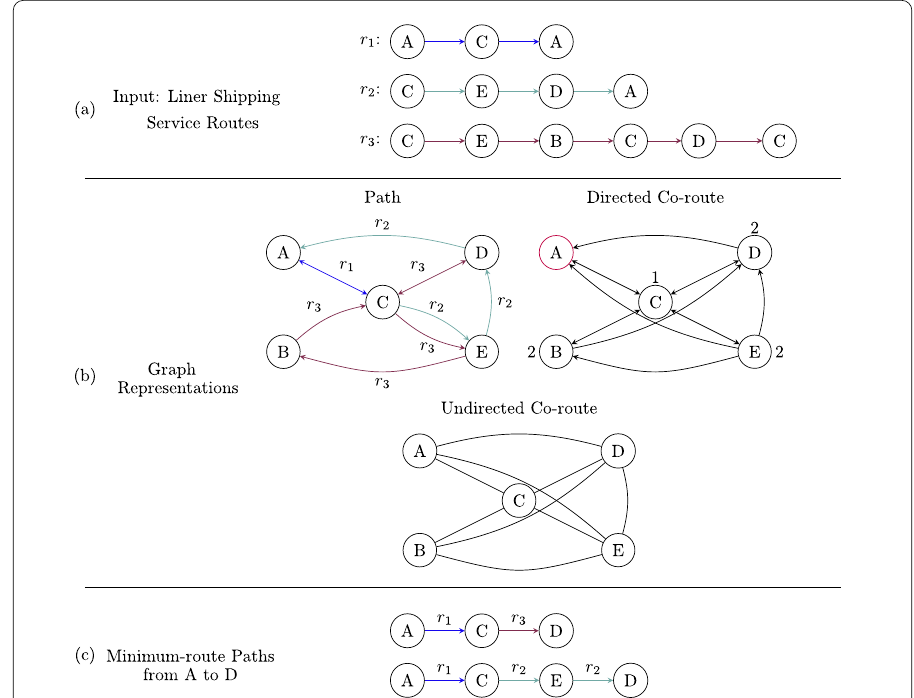
Figure 1 Examples of the three representations of liner shipping service route data studied in this paper. The input data is three routes, labeled r 1 , r 2 , and r 3 , visiting the ports A, B, C, D, E. The path graph is the traditional directed network representation of the routes, where an edge exists from u to v if the edge appears in at least one route. We also add parallel edges for every route in which the edge exists (or equivalently keep a set of route labels for each edge). This graph represents how ships and cargo can move through the network. The directed co-route graph is also a directed graph, but an edge exists from port u to port v if in at least one route port v appears in any succeeding ports of call after port u. The length of the shortest path between any two pairs of nodes in the co-route graph is the minimum-route distance (distances from A shown in ( b )). In the undirected co-route graph, every route is made into a clique, or fully connected undirected graph. This representation was used for service route data in previous work [11], emphasizing that cargo transportation between any two ports in a same route can be realized by one single vessel. All minimum-route paths between A and D, which require two routes and do not allow any port to appear more than once, are